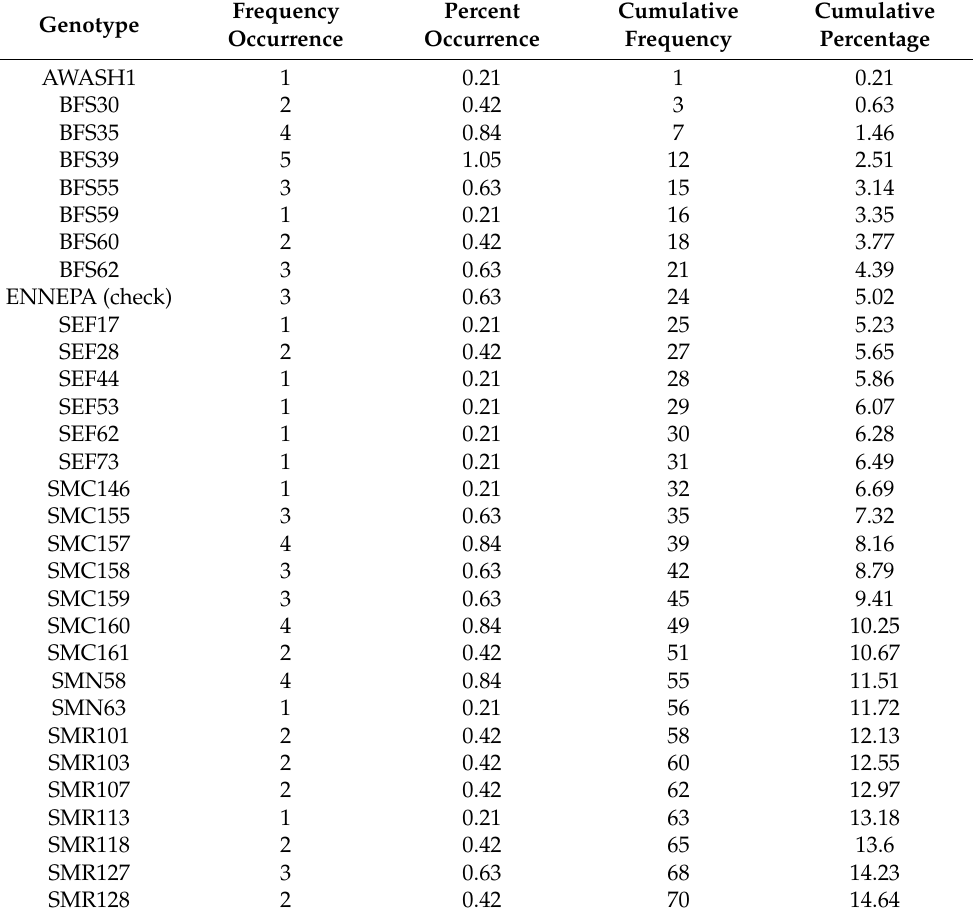
Table 7. Flower abortion frequency of drought-tolerant common bean genotypes during termi- nal